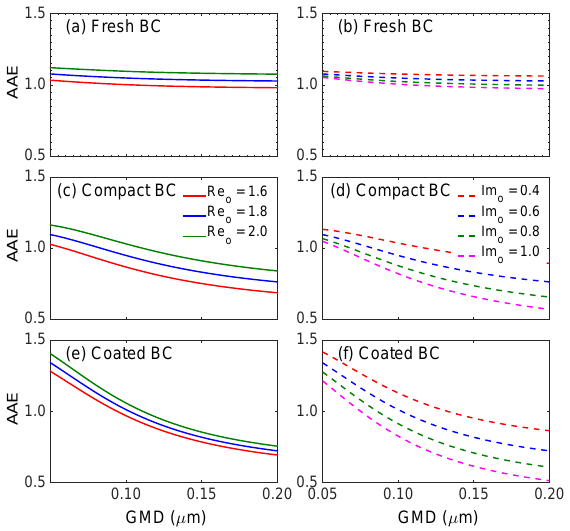
Figure 7. Influence of wavelength-independent refractive index on the AAEs of the fresh BC (a, b) , compact BC (c, d) , and coated BC (e, f) . A fixed imaginary part of 0.6 is used for panels (a, c, e) , and a fixed real part of 1.8 is used for panels (b, d, f) .